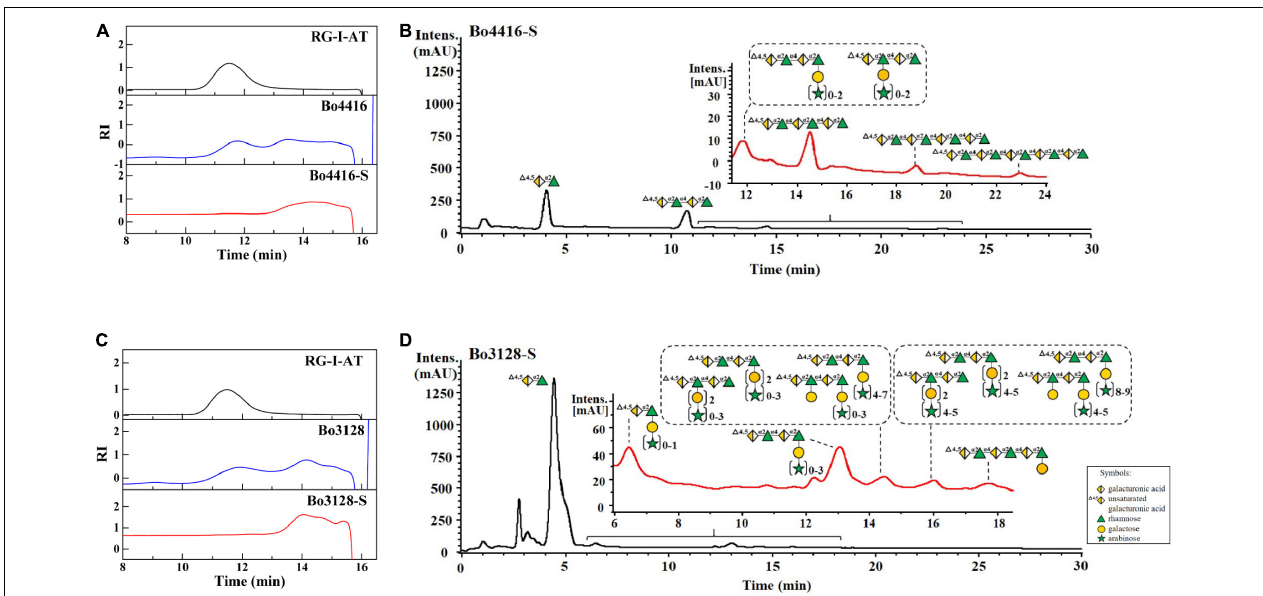
FIGURE 4 | HPGPC and UPLC-MS analysis of enzymatic products of Bo3128 (A,B) and Bo4416 (C,D) released from RG-I-AT. RG-I-AT: RG-I-AT before enzymolysis; Bo3128 and Bo4416: enzymatic products of Bo3128 and Bo4416; and Bo3128-S and Bo4416-S: oligosaccharide fraction of Bo3128 and